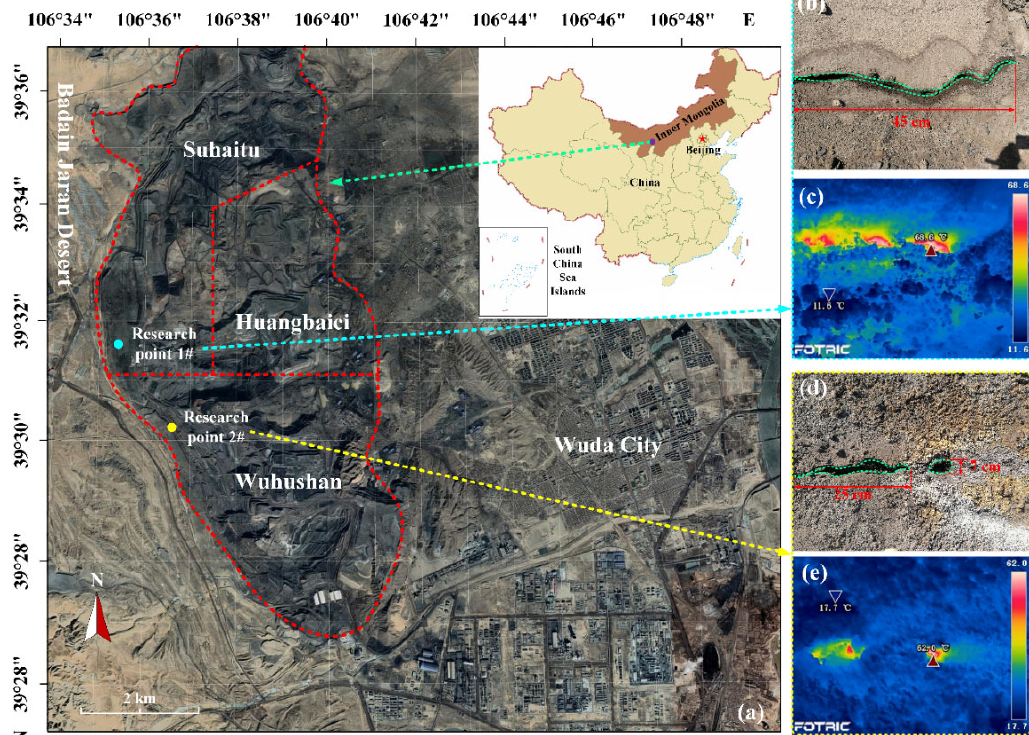
Figure 1. Location map of research points. ( a ) Research location; ( b ) Research point 1# fissure channel; ( c ) Research point 1# fissure temperature; ( d ) Research point 2# fissure channel; ( e ) Research point 2# fissure temperature.